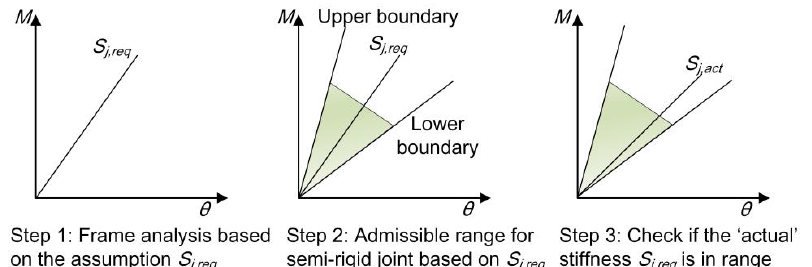
Figure 3. Check of a ‘actual’ semi-rigid joint in Steenhuis et al. [32]. All columns are assumed to share the same profile with a gravity-concentrated load applied on their tops. The rotational stiffness of the beam – column joints is 𝑆 𝑗 and the line stiffness of beam and column are 𝑘 𝑏 = 𝐸𝐼 𝑏 𝐿 𝑏 ⁄ and 𝑘 𝑐 = 𝐸𝐼 𝑐 𝐿 𝑐 ⁄ , respectively. The linear stiffness ratio 𝜌 of beam to column is defined as Equation (3):